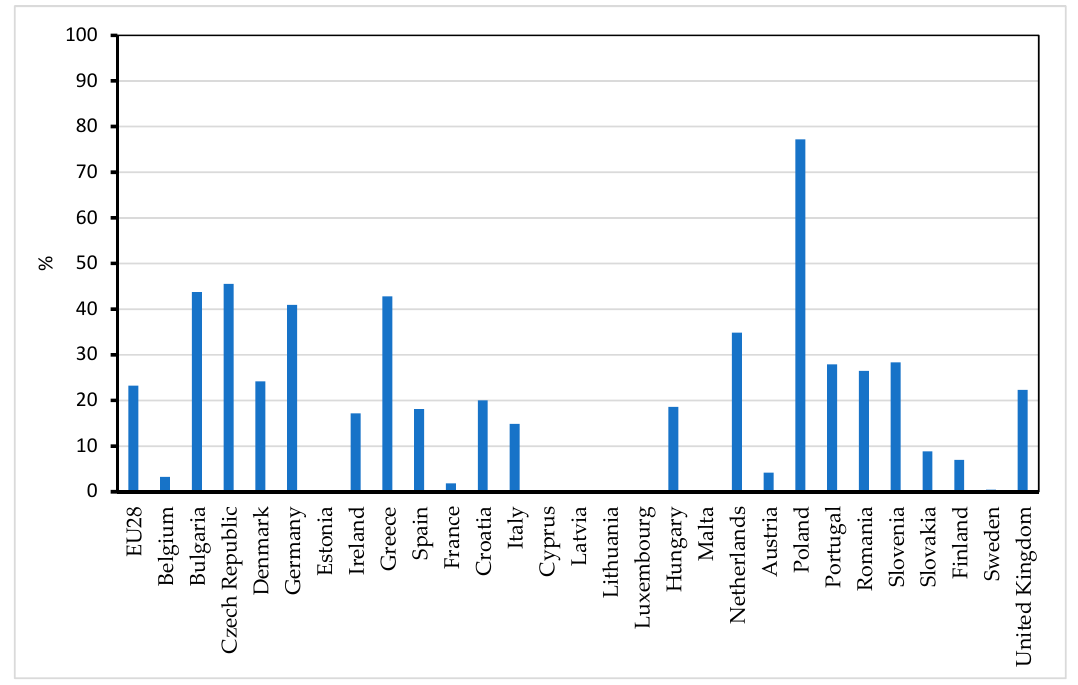
Figure 2. Share of electricity generation from coal and lignite in total electricity generation, EU—28 [16].